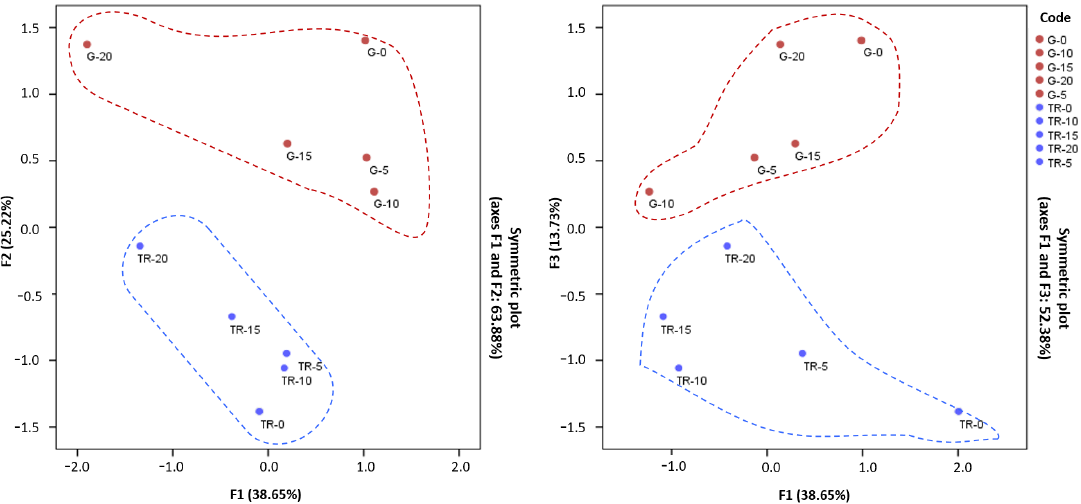
Figure 5. Principal components analysis in ‘Tintilla de Rota’ and ‘Graciano’ accessions during ripening period.